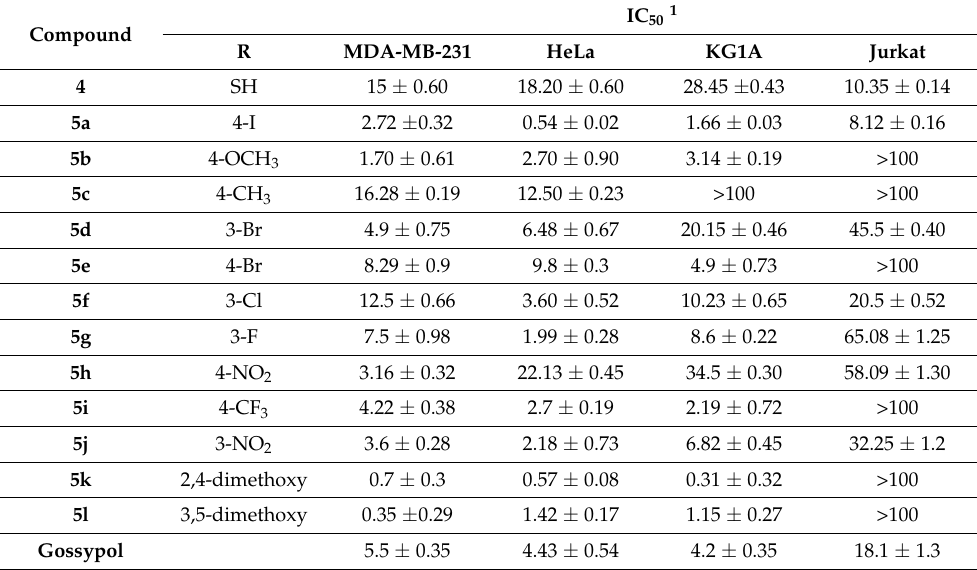
Table 1. Growth-inhibitory activity (IC 50 , µ M) values for compounds ( 4 , 5a – l ) against human cancer cell lines MDA-MB-231, HeLa, KG1a and Jurkat.